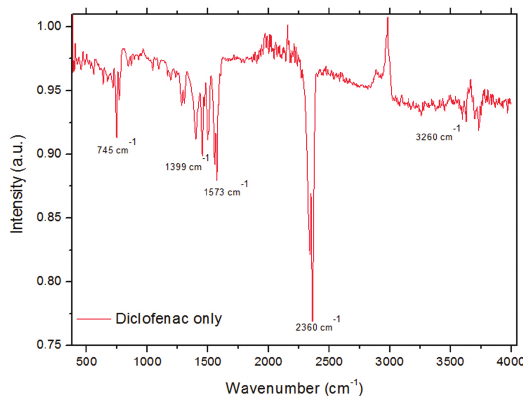
Figure 5. FT-IR spectra of sodium diclofenac in ATR method.